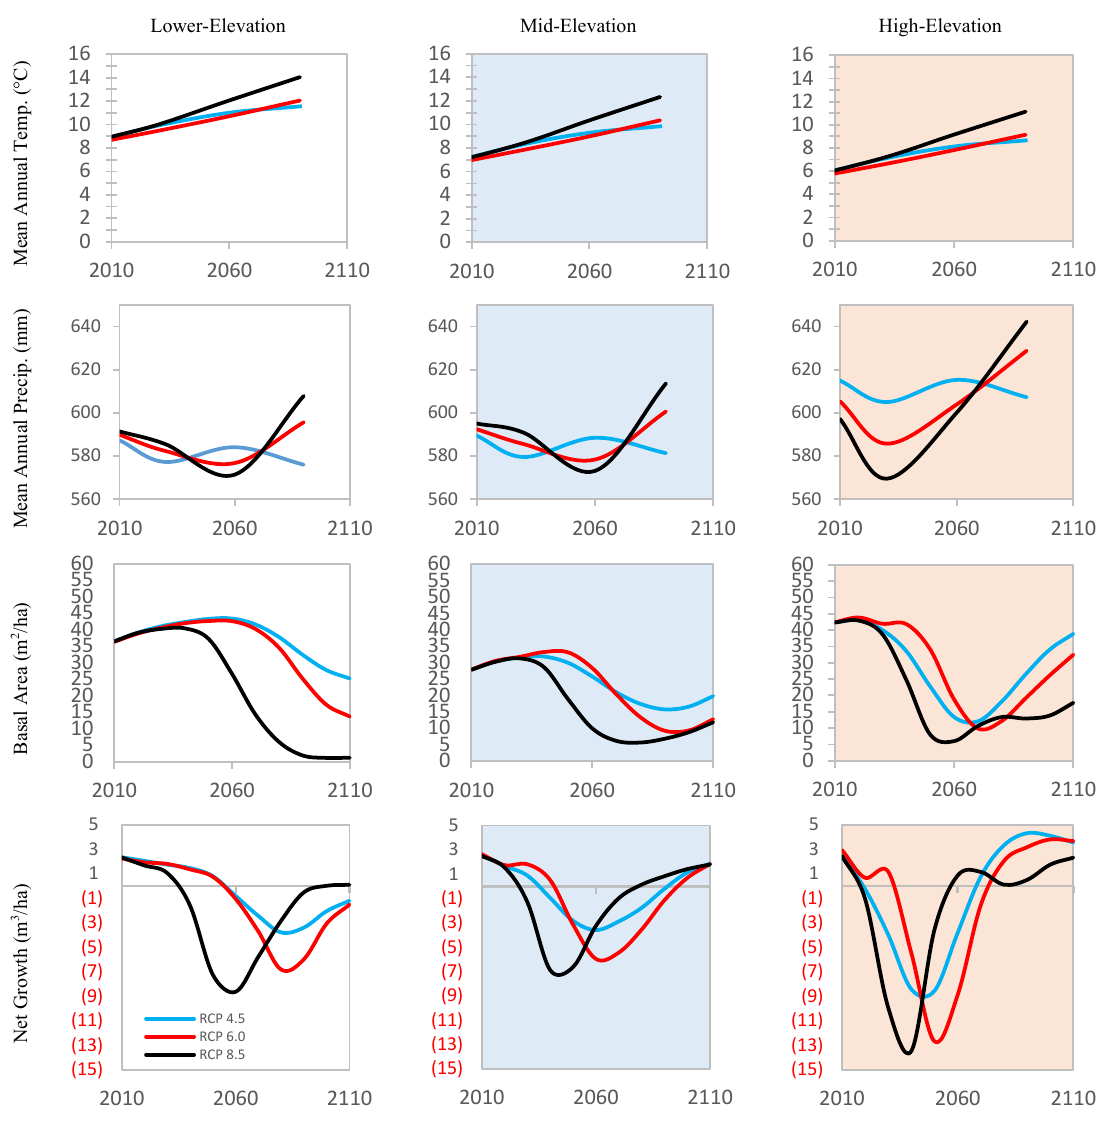
Figure 2. Conditions in stands projected for three elevational groupings (lower, medium, and higher elevation) under three warming climate scenarios, RCP 4.5 (Blue), RCP 6.0 (Red), and RCP 8.5 (Black). Projections do not simulate any forest management. Mean annual temperature (MAT) and mean annual precipitation (MAP) data were only available for 1990 to 2090. Basal area is measured in m 2 /ha. Net growth is calculated as average stand growth (m 3 /ha) minus average stand mortality (m 3